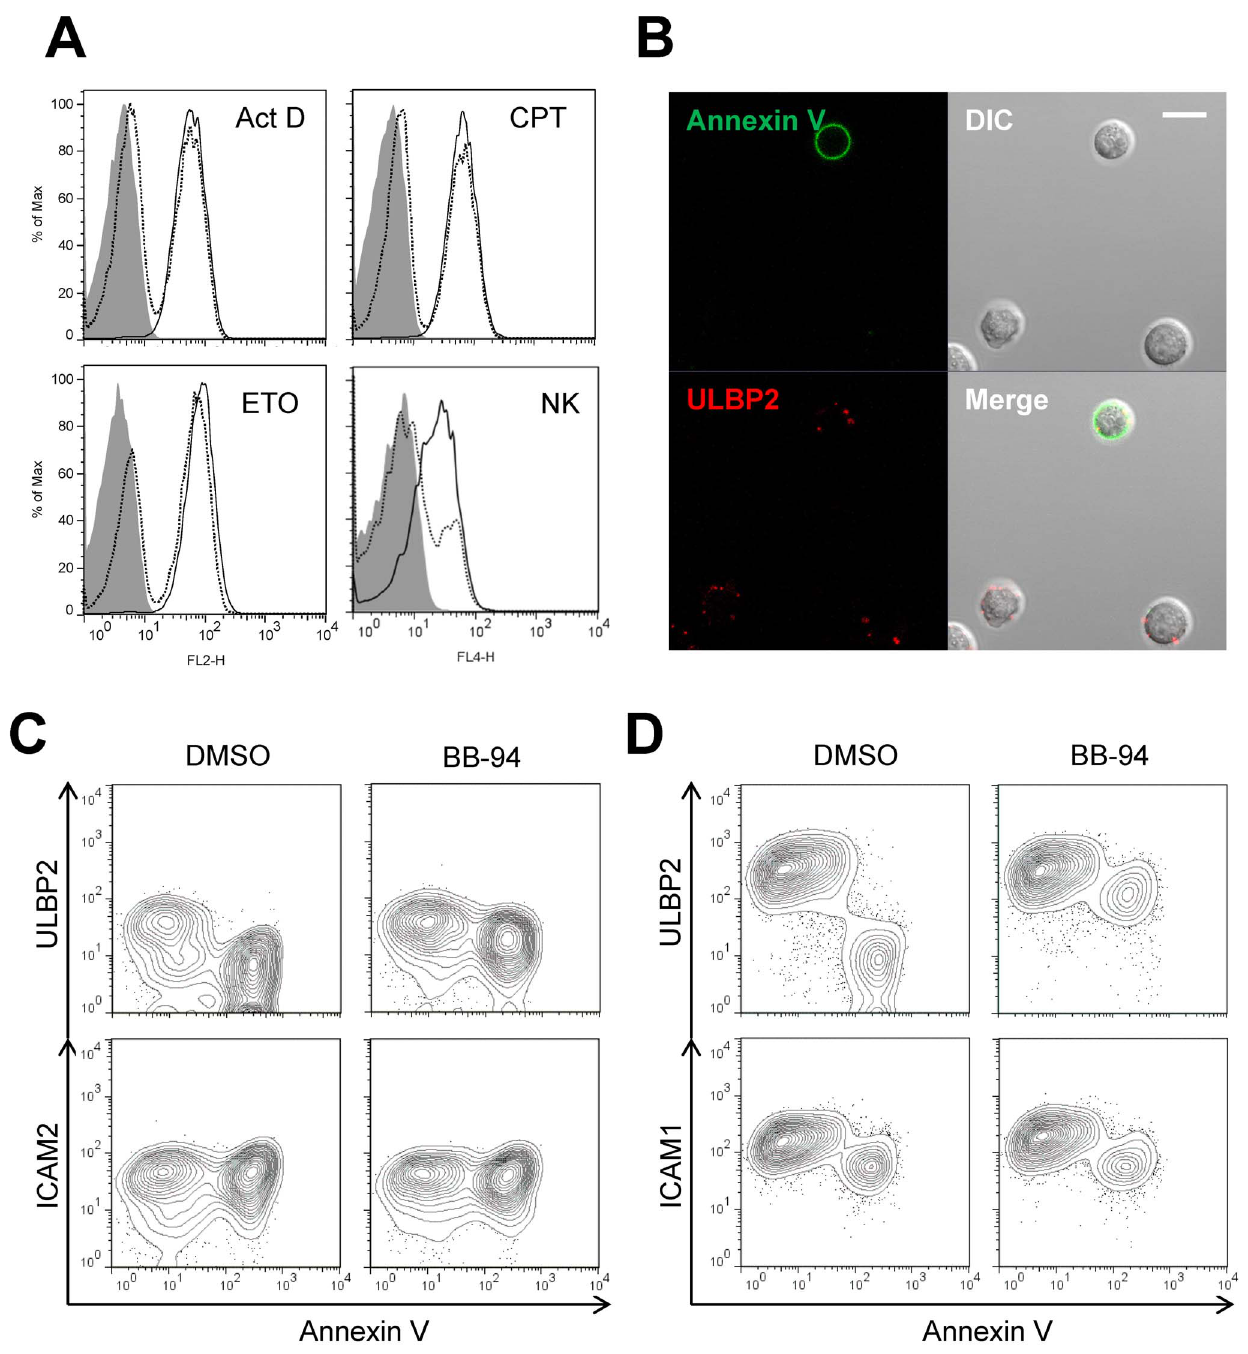
Figure 7. BB-94 rescues cell surface expression of ULBP2 in apoptotic cells. (A, B) BB-94 abrogates apoptotic compound-induced shedding of ULBP2. (A) Jurkat cells were treated with 2 m g/ml Act D, 4 m M CPT or 20 m M ETO for 4 hours in the presence or absence of BB-94. The treated cells were stained by PE-conjugated mouse anti-human ULBP2 antibodies, and then analyzed by flow cytometry. ULBP2 expression on control cells and BB-94 treated cells are shown in dotted lines and solid lines, respectively. PE-conjugated mouse IgG2a was used as an isotype control (gray-shaded). (B) Jurkat cells were treated with ActD for 2 hours in the presence of BB-94, and then ULBP2 and Annexin V staining was visualized by confocal microscopy. Scale bar, 10 m m. (C, D) BB-94 abrogates NK cell-mediated shedding of ULBP2. 10 5 Jurkat (B) or H9 cells (C) were incubated with ( + NK) or without ( 2 NK) equal number of IL-2 expanded peripheral blood NK cells at 37 u C for 2 hours. The resulting cell mixtures were stained by anti-human ULBP2 or ICAM1/2 antibodies, followed by APC-conjugated goat anti-mouse IgG antibody and Annexin V-PE staining, and then analyzed by flow cytometry. NK cells were excluded by FITC conjugated anti-human CD56 mAb staining. doi:10.1371/journal.pone.0091133.g007 apoptotic tumor cells. It is likely that the concentration of ULBP2 induced shedding. Spontaneous shedding of NKG2D ligands is from tumor patients results from both spontaneous and apoptosis- likely due to high expressions of metalloproteinases on tumor cells